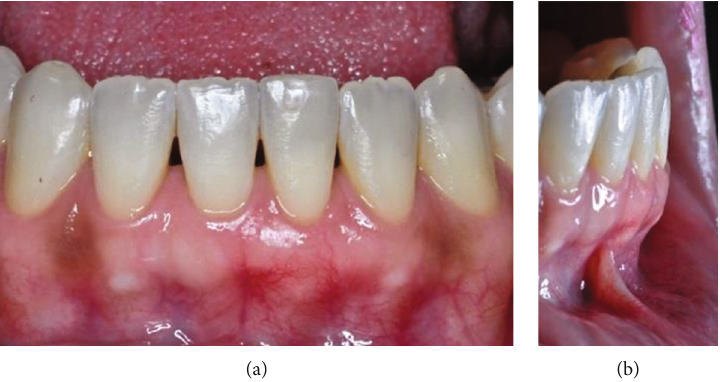
Figure 15: (a, b) Six months postoperatively.